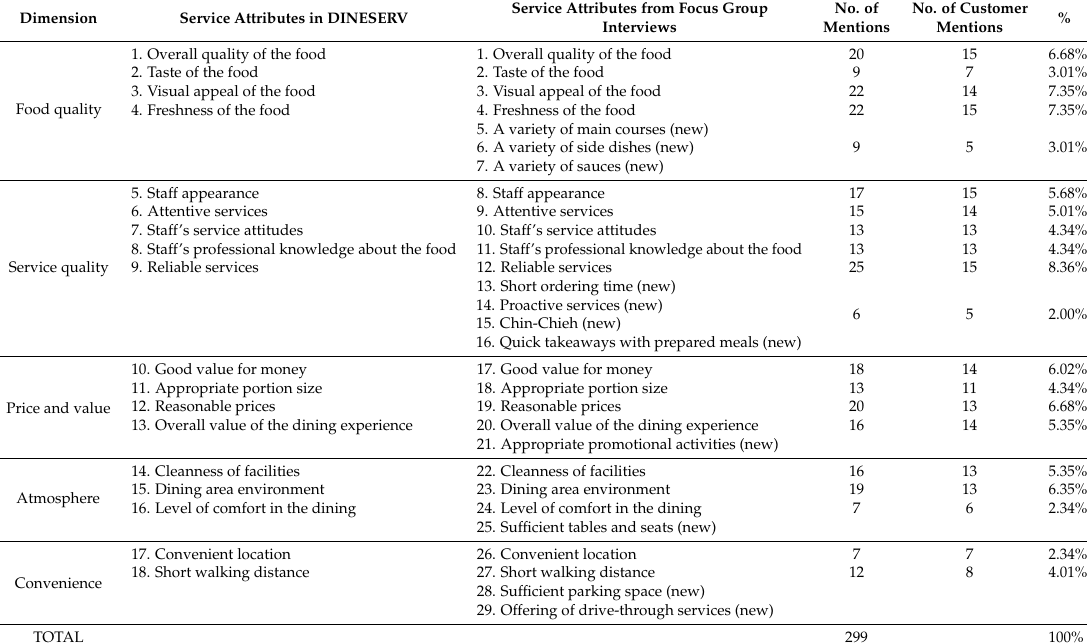
Table 4. Focus group interview